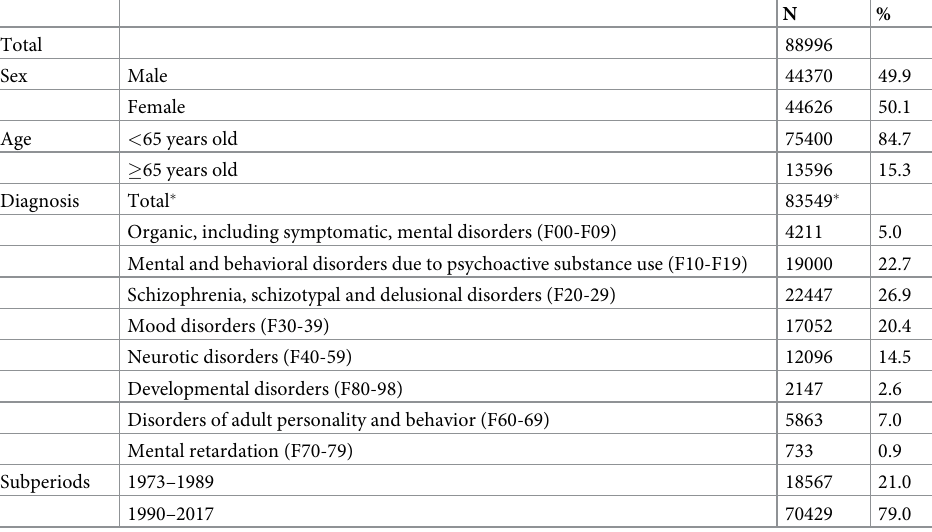
Table 1. Descriptive statistics for mental disorder hospitalizations in University Psychiatric Hospital Bern (Swit- zerland),